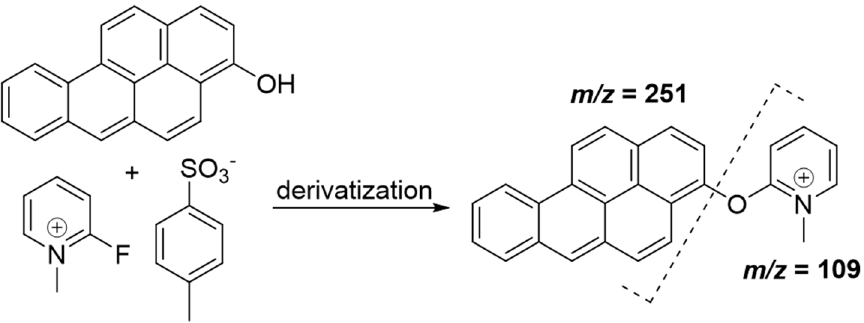
Figure 2. Derivatization of 3-OH-BaP with 2-fluoro-methylpyridinium-p-toluenesulfonate (FMPT).